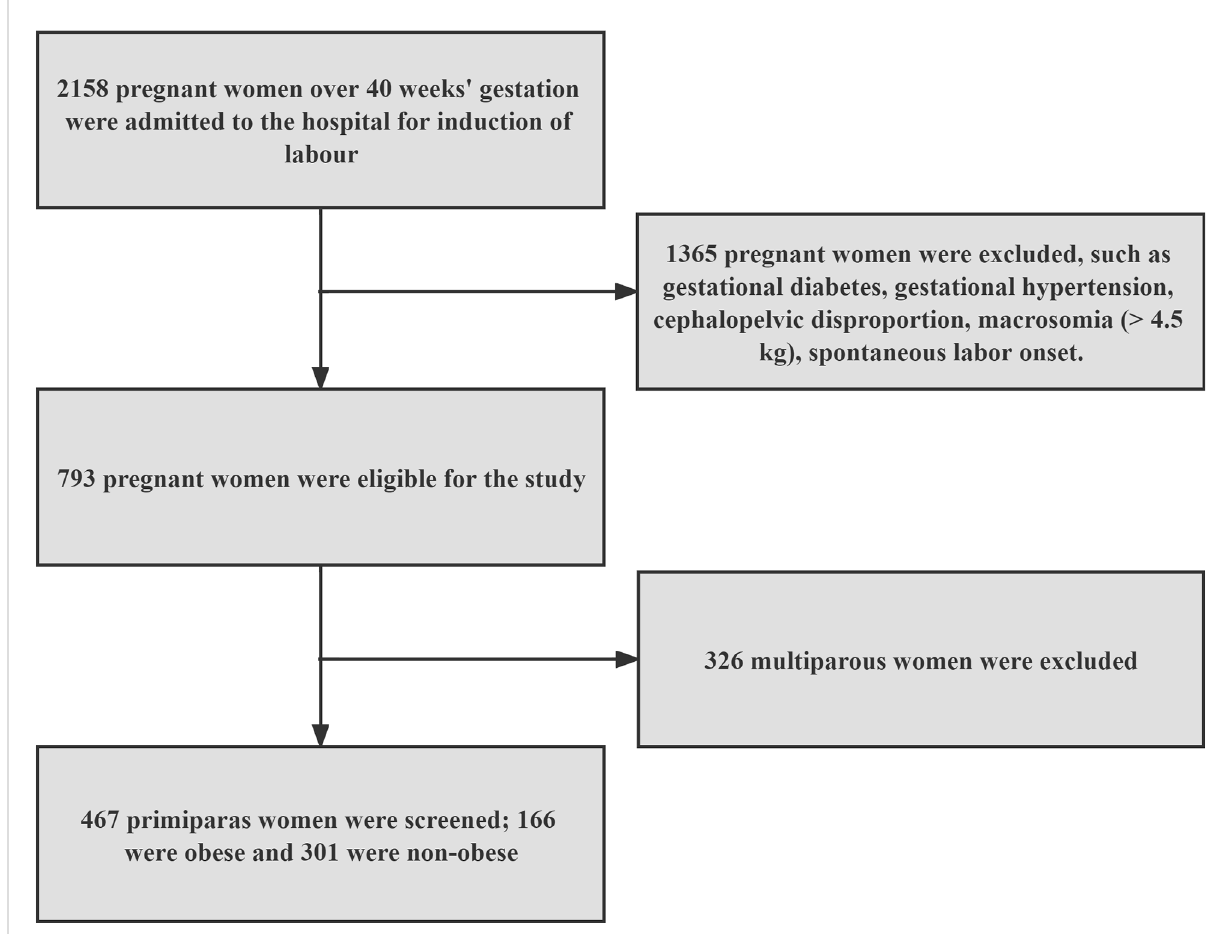
FIGURE 1 Flowchart of the research